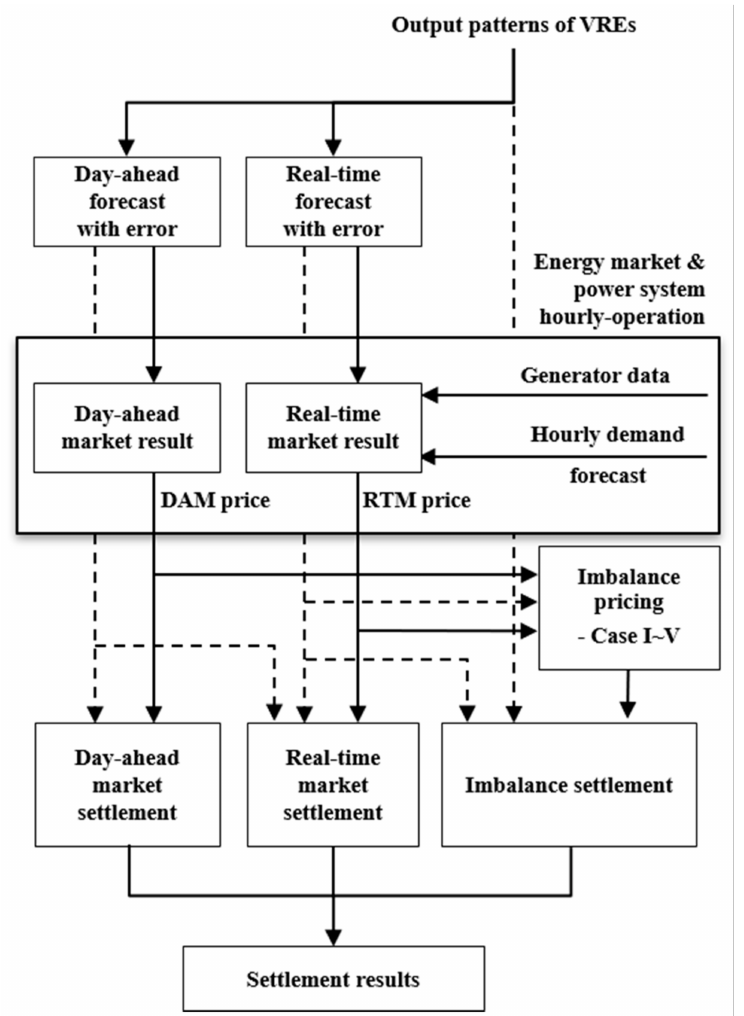
Figure 2. Schematic diagram of the comparison of imbalance pricing